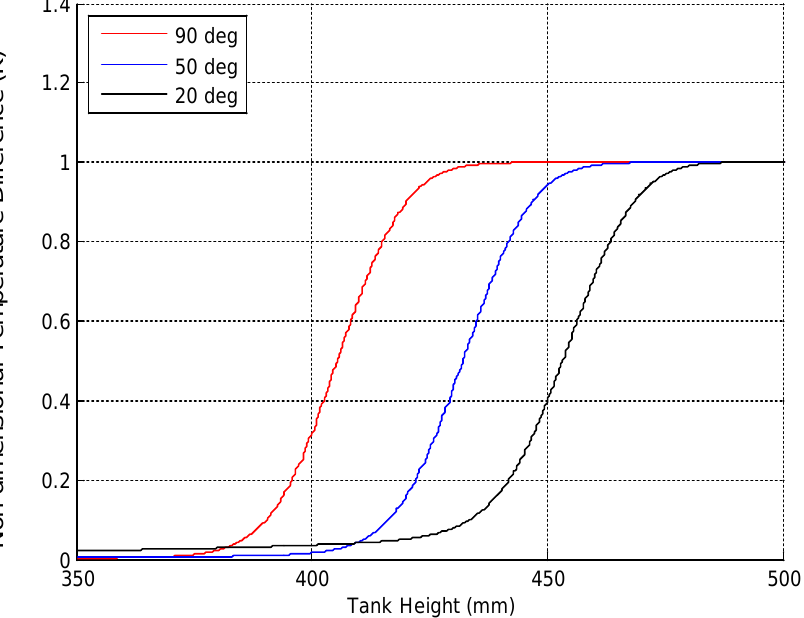
Figure 9. Temperature profiles with tank height in TES-1 at different temperature differences.